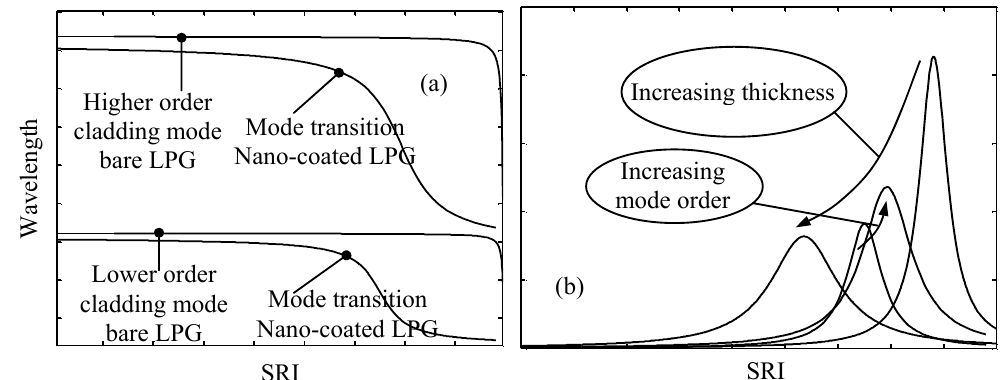
Figure 20. Conceptual description of the modal transition in nano-coated LPGs; (a) comparison of the dips shift behavior in the bare device and in the coated one; (b) sensitivity characteristics in the coated device for fixed cladding mode and varying overlay